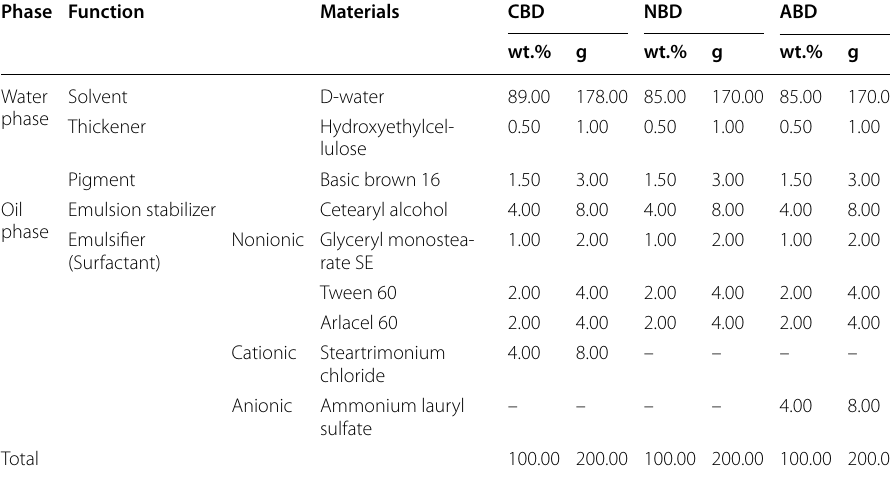
CBD cationic basic hair dye, NBD nonionic basic hair dye, ABD anionic basic hair dye